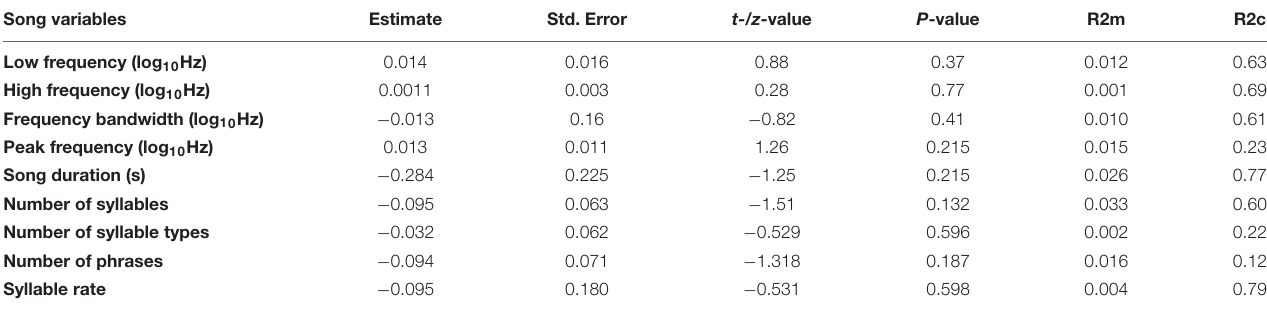
FIGURE 3 | Relationship between noise level and bananaquit song variables. In noisier situations, bananaquits sing higher songs (A) , do not change the song syllable length (B) , nor the syllable diversity (C) . The lines represent the fitted linear model for significant results. In graph A, blue lines and dots represent the minimum frequency and the red line and dots represent the maximum frequency. TABLE 2 | Fitted linear mixed models of the spectral or temporal or elaboration song variables on the bird